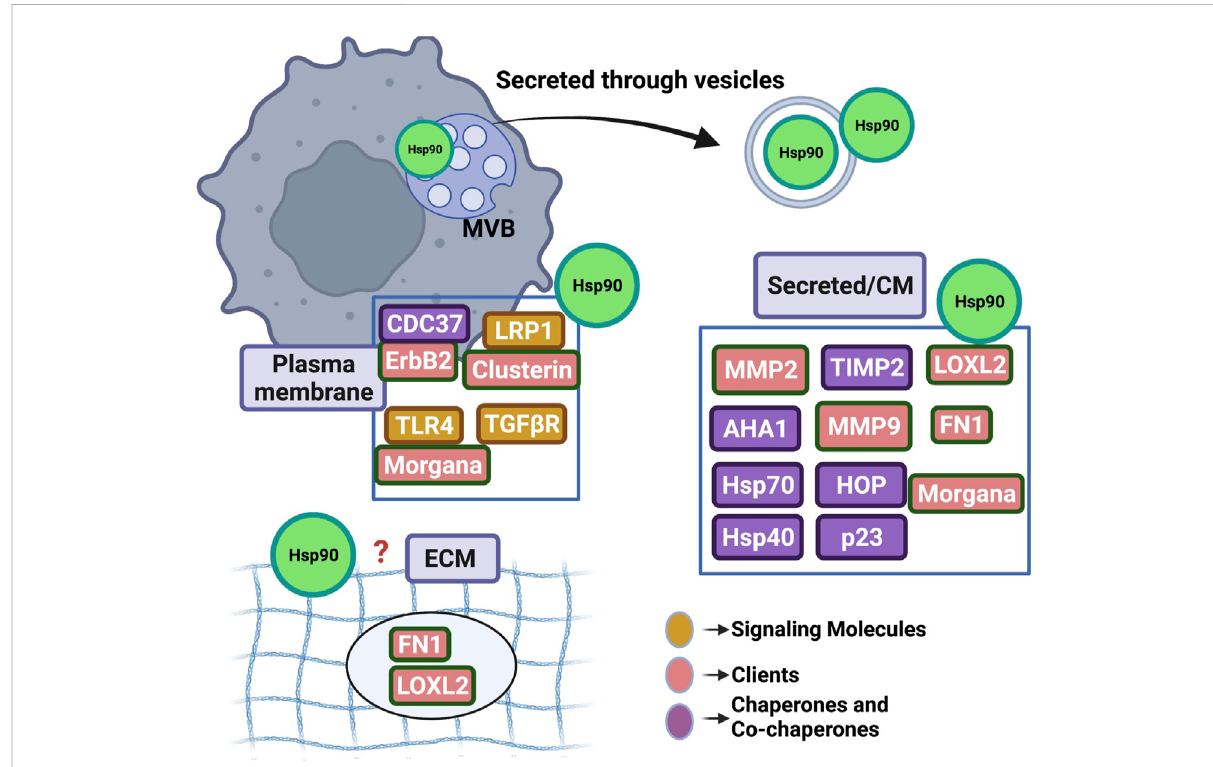
Highlighting the ubiquitous presence of Hsp90 in the extracellular space. Hsp90 (represented as green circle) has been detected at multiple sitesincludingtheouterplasmamembrane,freeinconditionedmedia(CM)andassociatedorenclosedintoextracellularvesicles.Studiescitedinthis manuscript have shown eHsp90 binding directly or indirectly to several secreted protein clients, co-chaperones or signaling molecules. Although eHsp90 associates with extracellular matrix components (ECM), it remains to be found if the chaperone incorporates in the ECM structure. MVB; multivesicular body in the cytosol uptaking Hsp90 that will be released in the extracellular space following